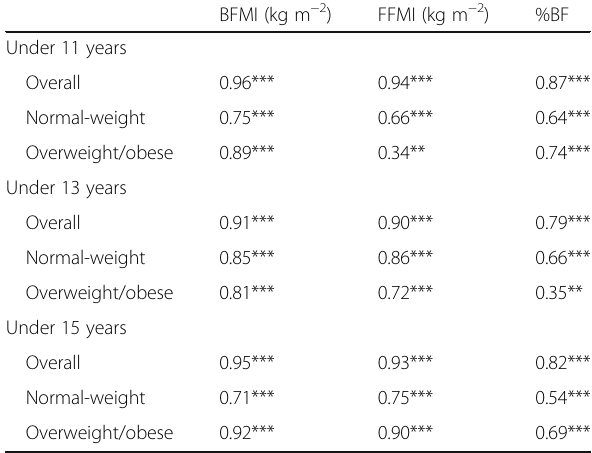
Table 3 Pearson correlation coefficients between body mass index, body fat mass index, fat-free mass index, and percentage of body fat in young male rugby